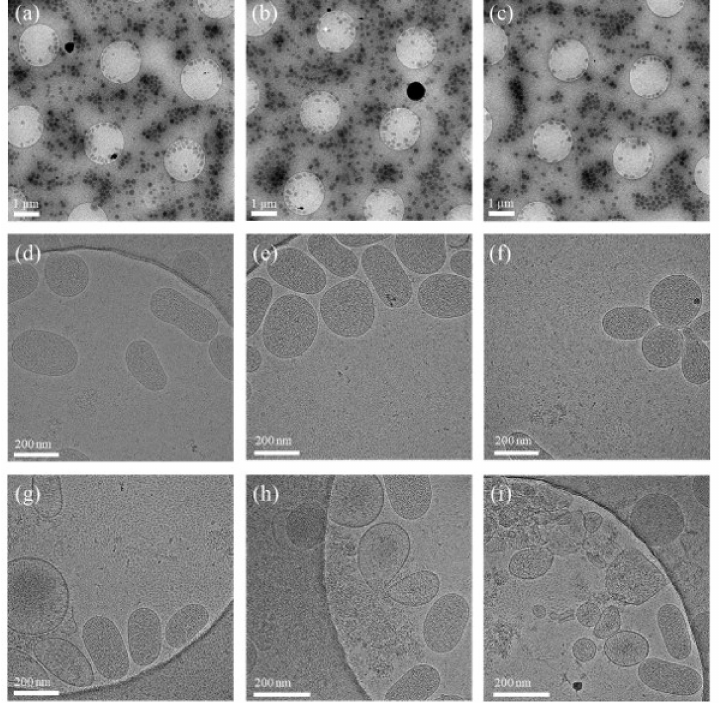
Figure A3. Cryo-TEM images of hbEVs isolate at low ( a – c ) and high ( d – i ) magnification, taken 7 months after isolation. When considering the shape and size of hbEVs, the thickness of the ice should be between 80 and 150 nm and the visible contours do not necessarily represent the three-dimensional shape of